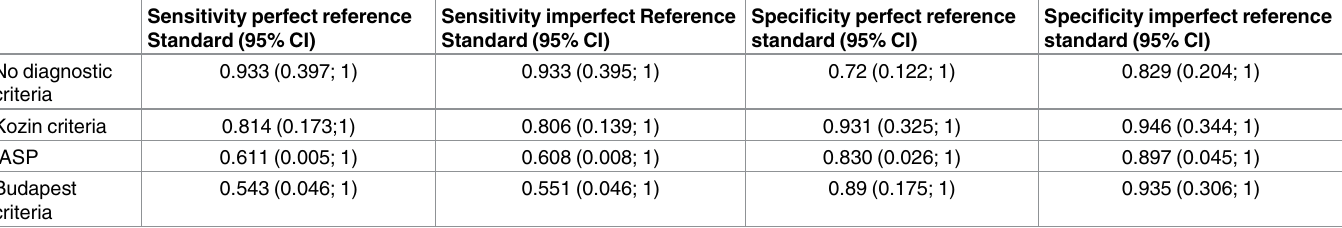
Table 2. Meta-analysis of diagnostic accuracyfor bone